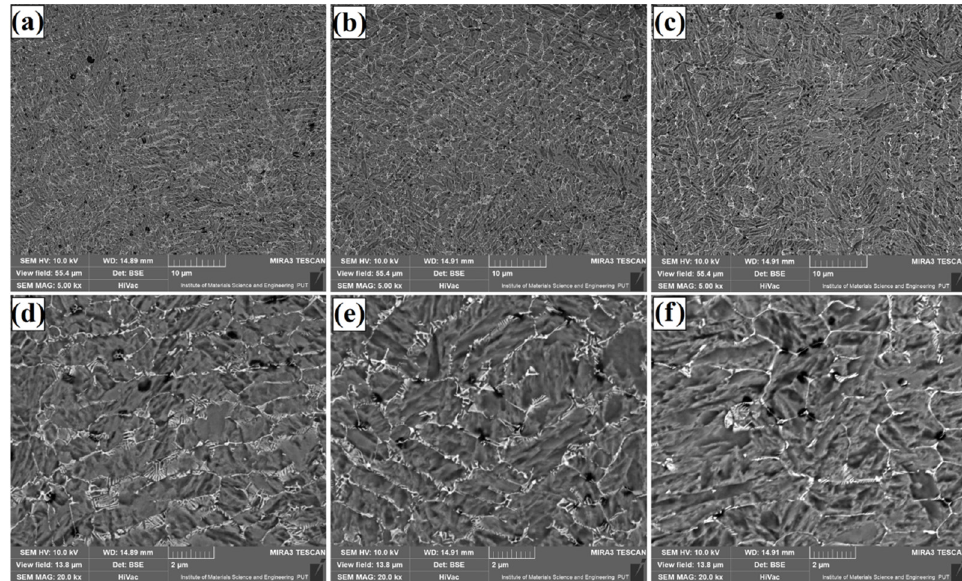
Figure 7. Subsurface area of the Fe/TaC coatings produced on tool steel using 60 µm thick pre-coat and laser beam power of 500 W ( a , d ), 800 W ( b , e ), 1100 W ( c , f ).